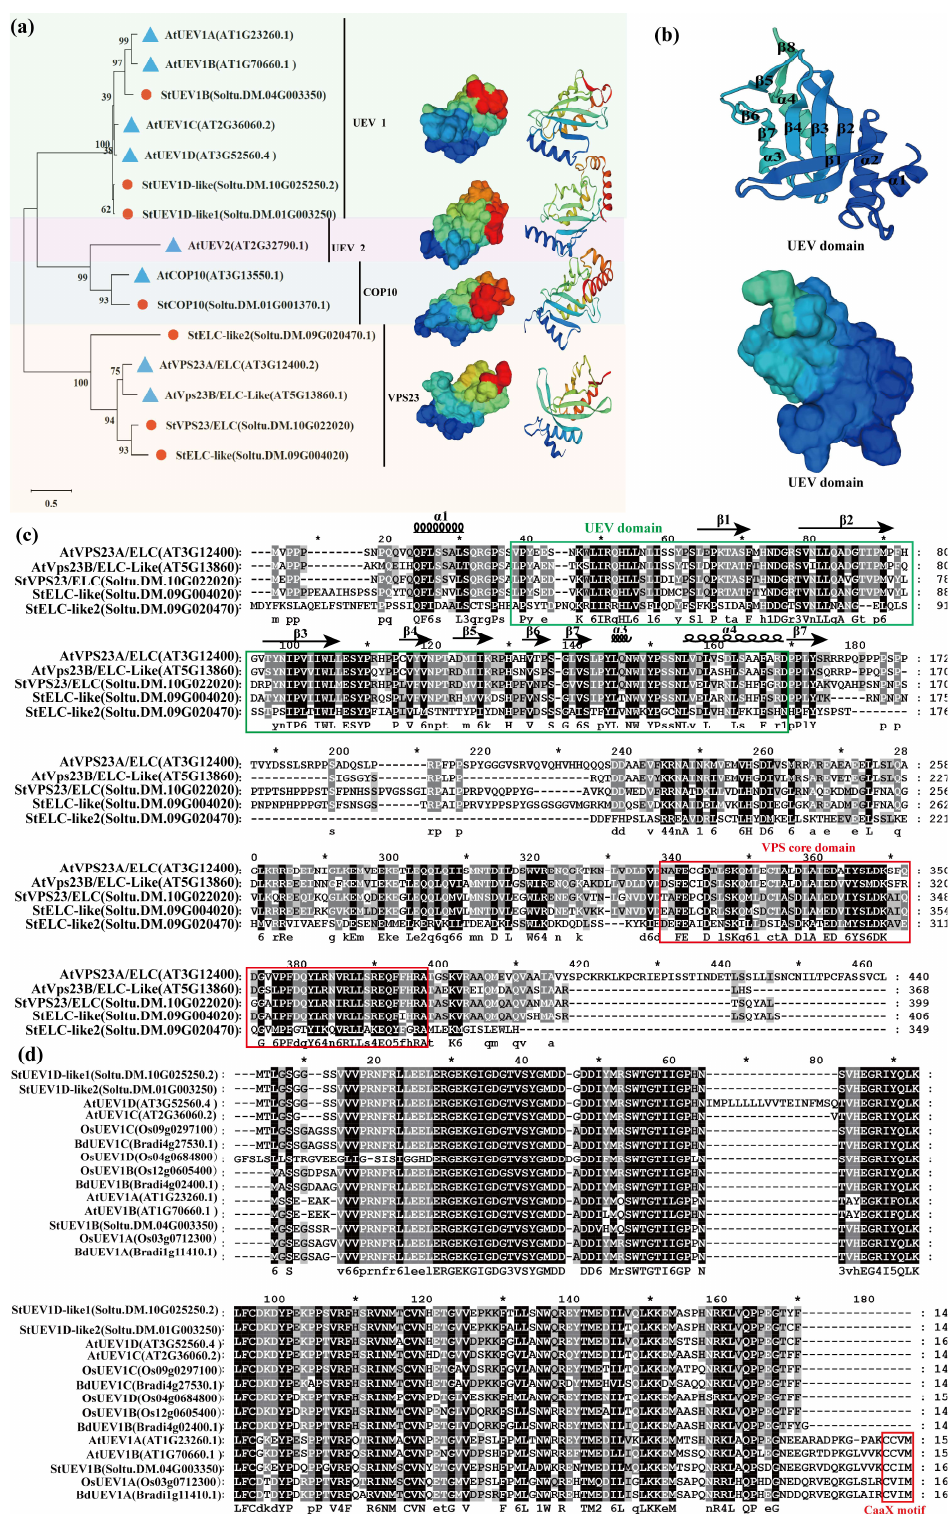
Figure 1. Characterization analysis of UEVs gene family. ( a ) Phylogenetic relationships and classification of UEVs gene family. ( b ) The three-dimensional structure of UEVs conserved domain. ( c ) Protein sequence alignment of VPS23 subgroups in Arabidopsis and potato. ( d ) Protein sequence alignment of UEV1s subgroups from Oryza sativa , Arabidopsis thaliana , Brachypodium distachyon , and Solanum tuberosum